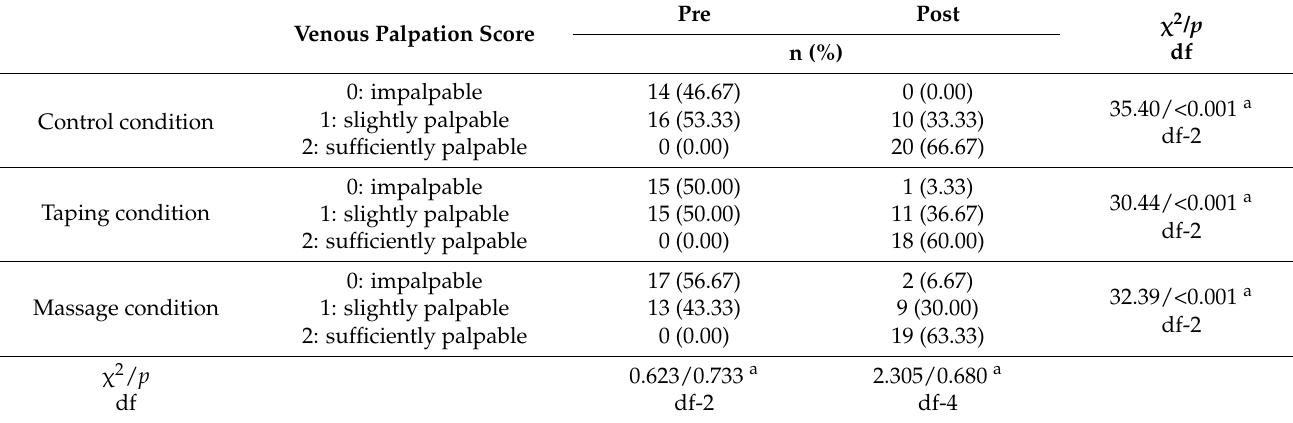
Table 3. Change in venous diameter and depth (n =